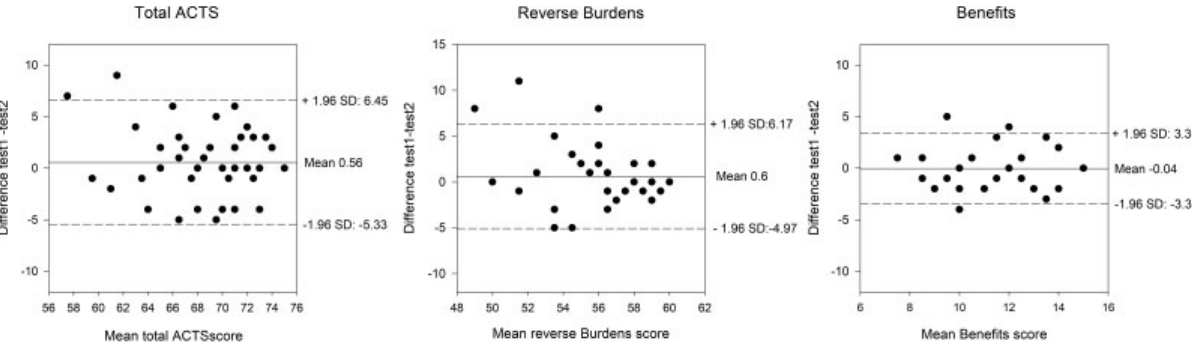
Fig. 4 Bland – Altman plots for two measurements in stable patients. Solid lines indicate the mean difference, while the dashed lines indicate the 95% limits of